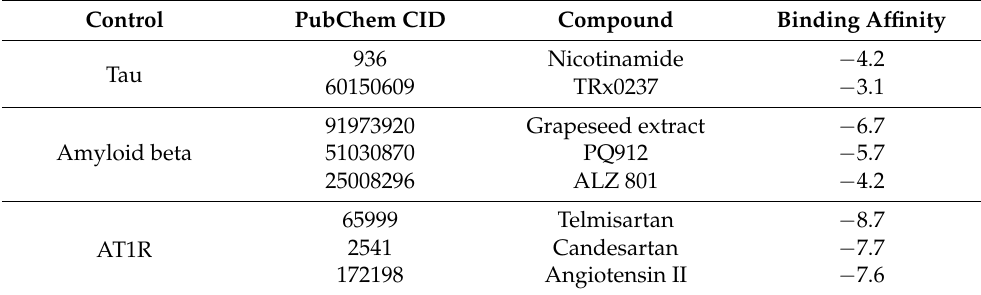
Table 1. Values of binding affinity [kcal/mol] of control ligand molecules relative to target peptides obtained during docking